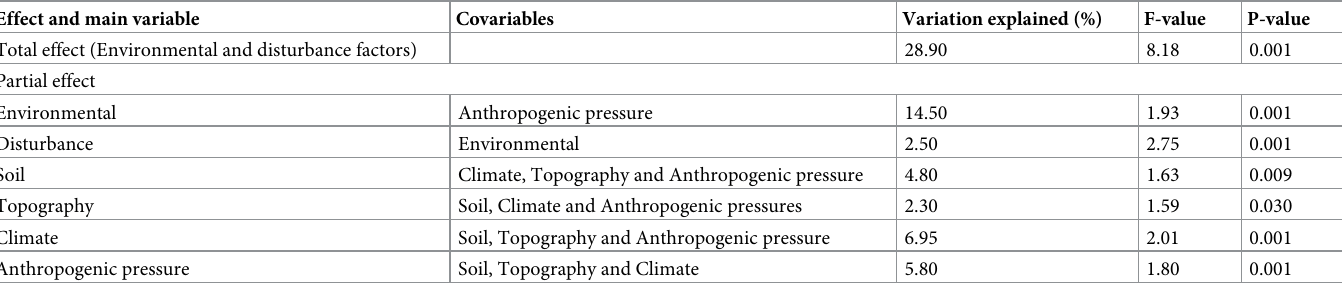
Table 2. CCA variation partitioning (%) on overall plant species composition of Tropical sub- montane forests of East Usambara, Northern Tanzania.